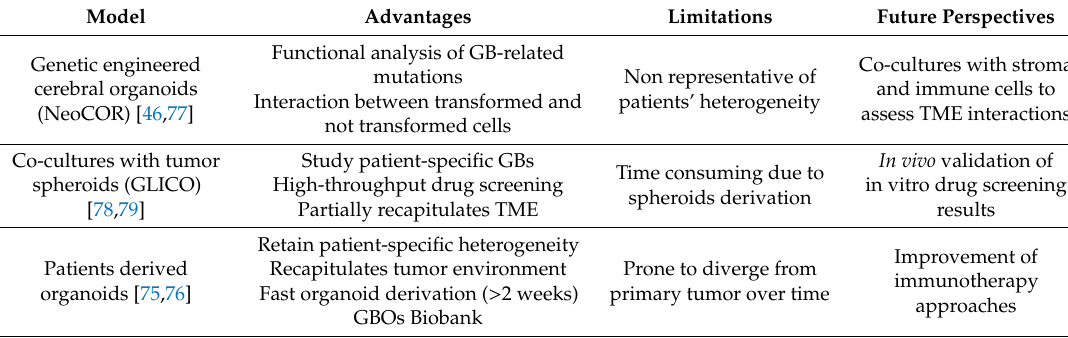
Table 2. Advantages and disadvantages of glioblastoma